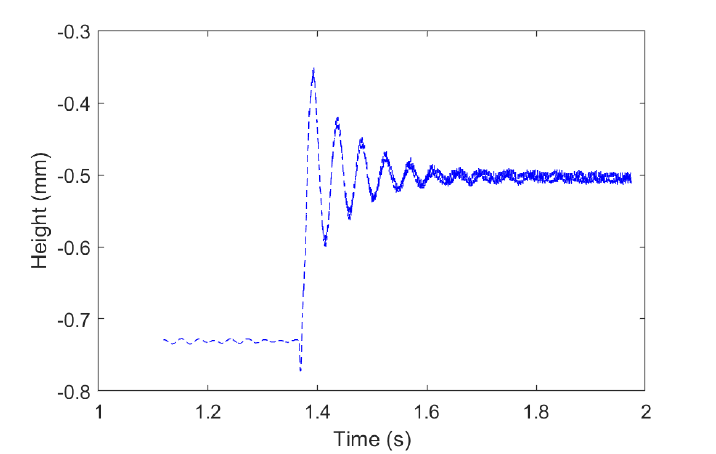
Figure 12. Displacement at tip of amplification mechanism tip, after a 347 Hz, 40 V input to the PZT bender is initiated at 1.35 s, showing quasi-static elevation of beam